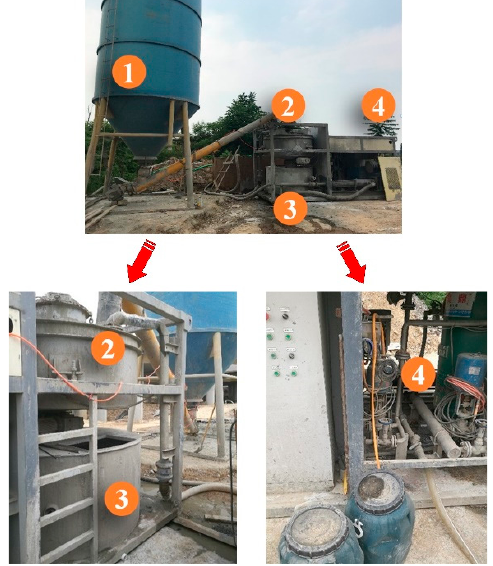
Figure 5. The preparation equipment for foamed concrete specimens.